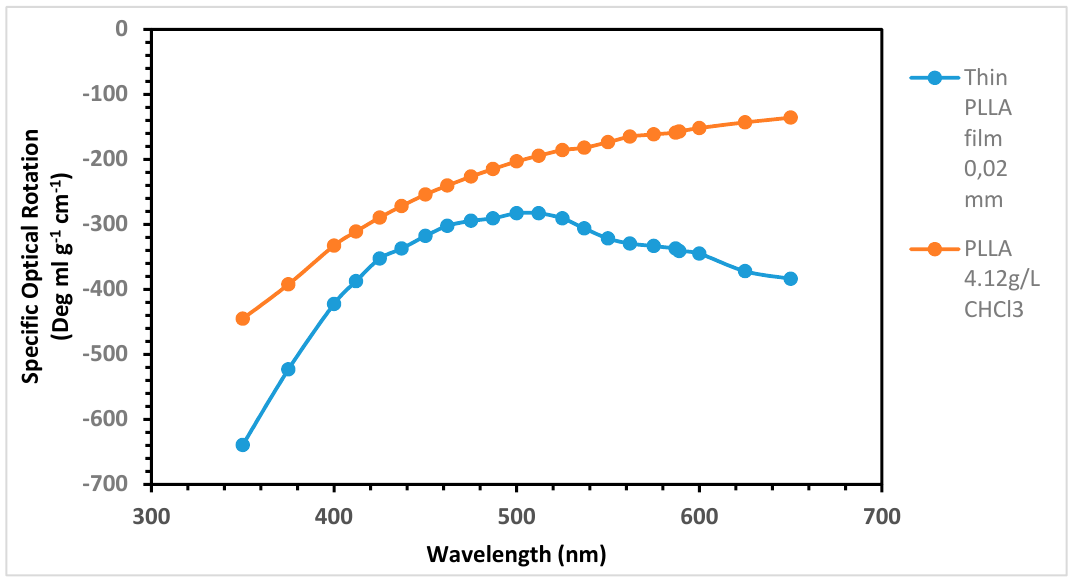
Figure 4. Optical rotatory dispersion (ORD) of a PLLA solution in CHCl 3 (4.12 g/L) (orange line and dots) in comparison